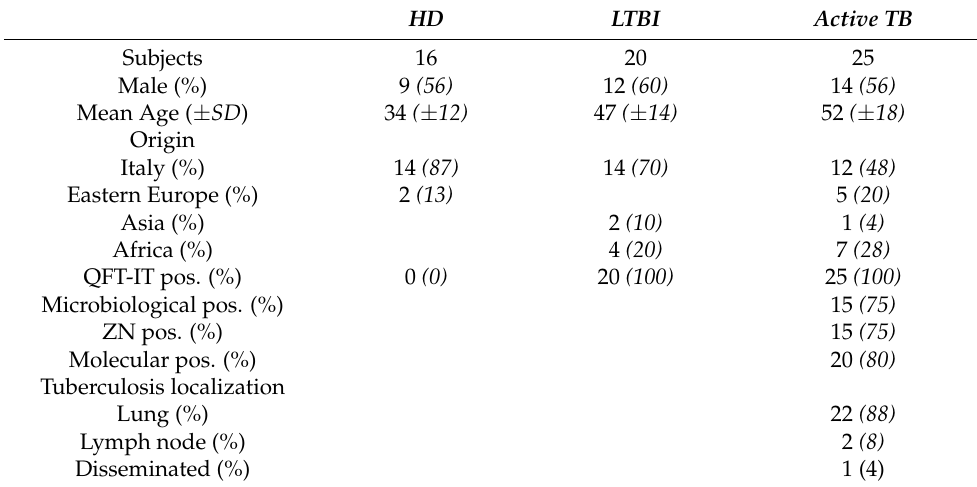
Table 1. Characteristics of study